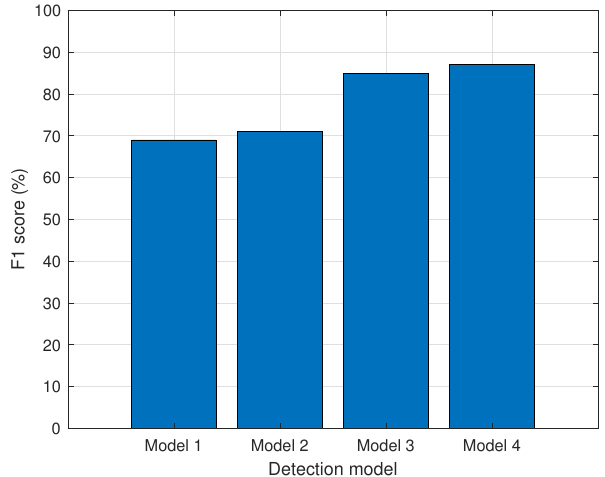
Figure 4. F1 score for each recognition model.